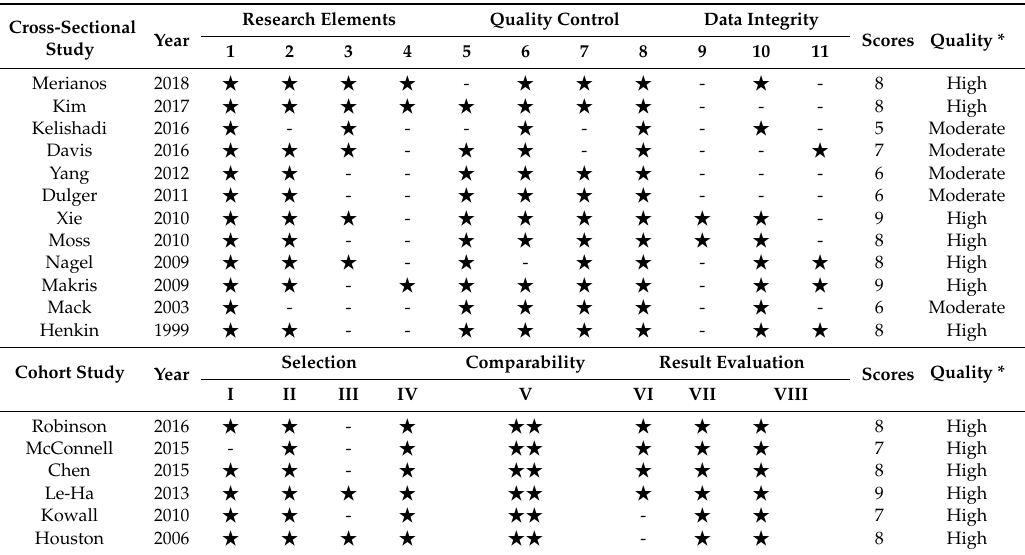
Table 2. Quality assessment of included studies.